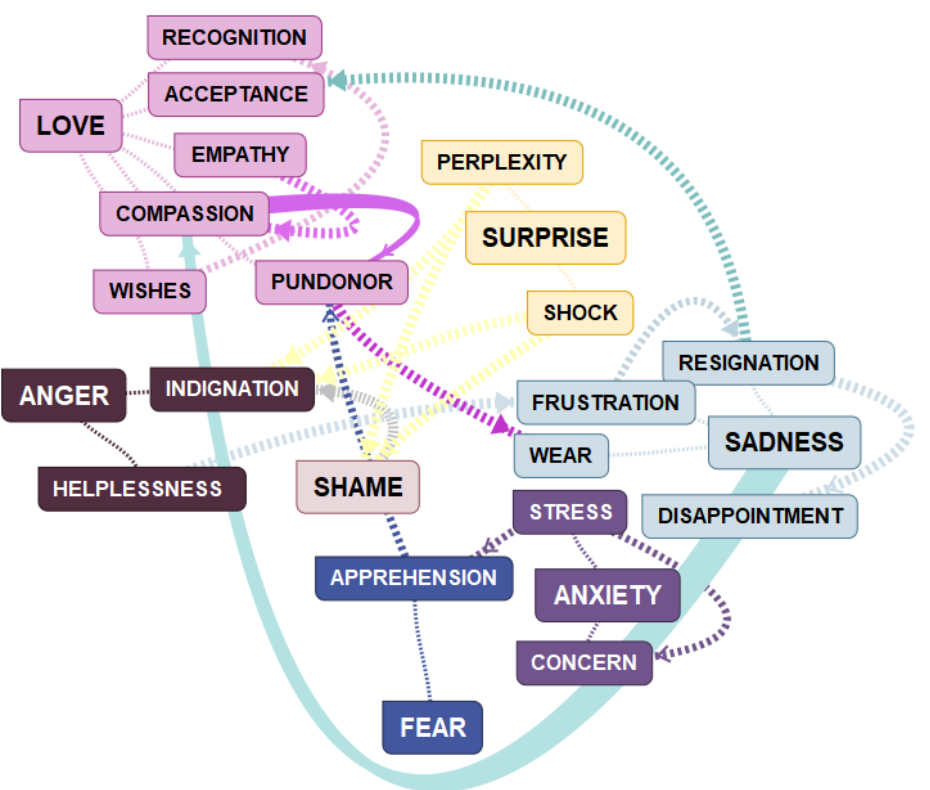
Figure 2. Emotional Universe of NCM in the care of elderly people at risk in Spain.